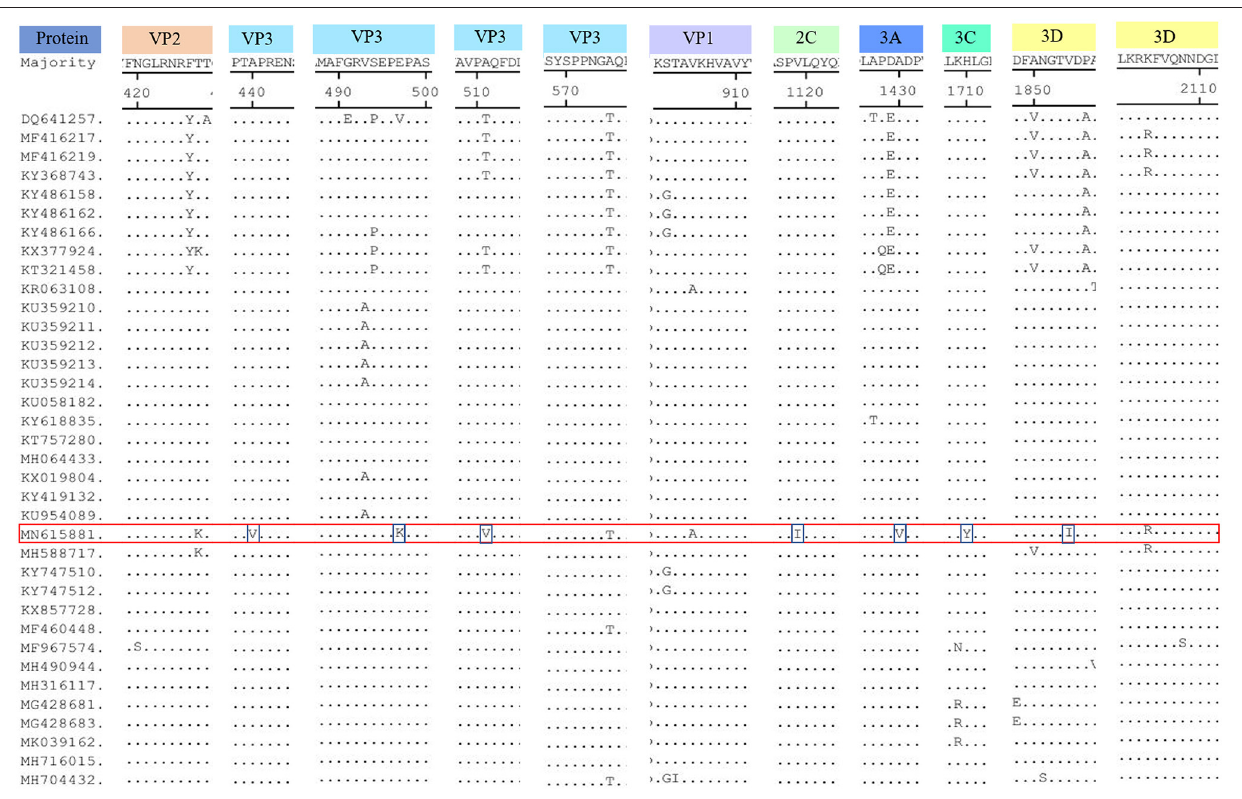
FIGURE 3 | Amino acid sequence alignment of the polyproteins. The SVA/GD/China/2018 strain had seven different amino acids, including 440A (alanine)—V (valine), 497E (glutamic acid)—K (lysine), 511A (alanine)—V (valine) at the VP3 protein; 1119V (valine)—I (isoleucine) at the 2C protein; 1430A (alanine)—V (valine) at the 3A protein; 1710H (histidine)—Y (tyrosine) at the 3C protein, 1854V (valine)—I (Isoleucine) at the 3D protein. For mutations pertaining to amino acids at position 427K (lysine, VP2 protein), 2104R (arginine, 3D protein) was the same as the first wild boar strain, Sichuan HS-01, in China. The “red frame” indicates the buffalo-origin Seneca Valley virus sequence we isolated, and the “blue frame” indicates the different amino acids compared with other